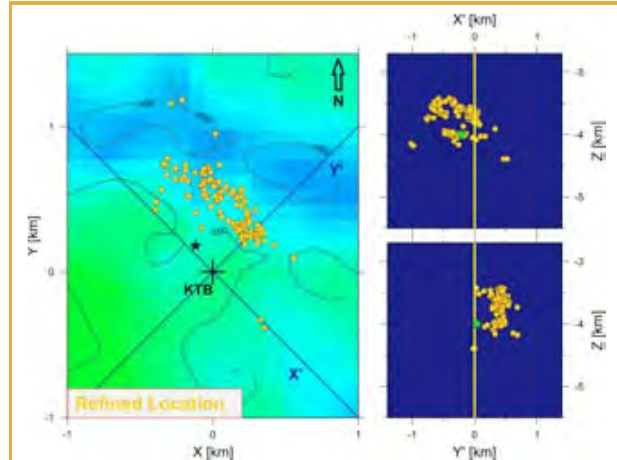
Figure 3. Locations of largest induced seismic events using a refined local 3D velocity model with projections on surface (left) and on X’-Z and Y’-Z planes (right). Asterisk marks bottom hole position of KTB- VB. Coloring on left reflects topography, contour lines indicate eleva- tion in meters above sea level.